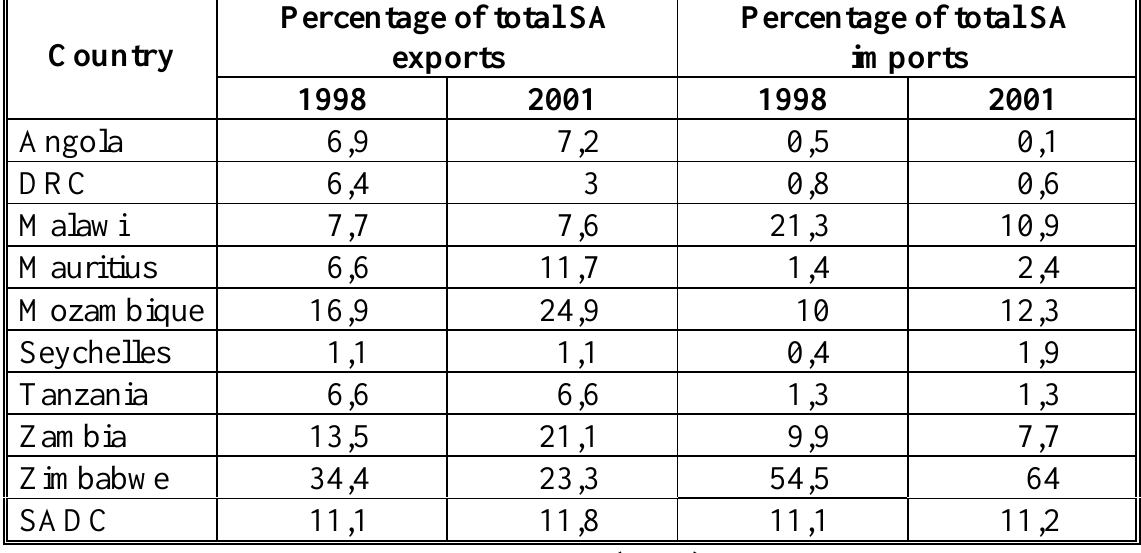
Percentage of total SA imports Country